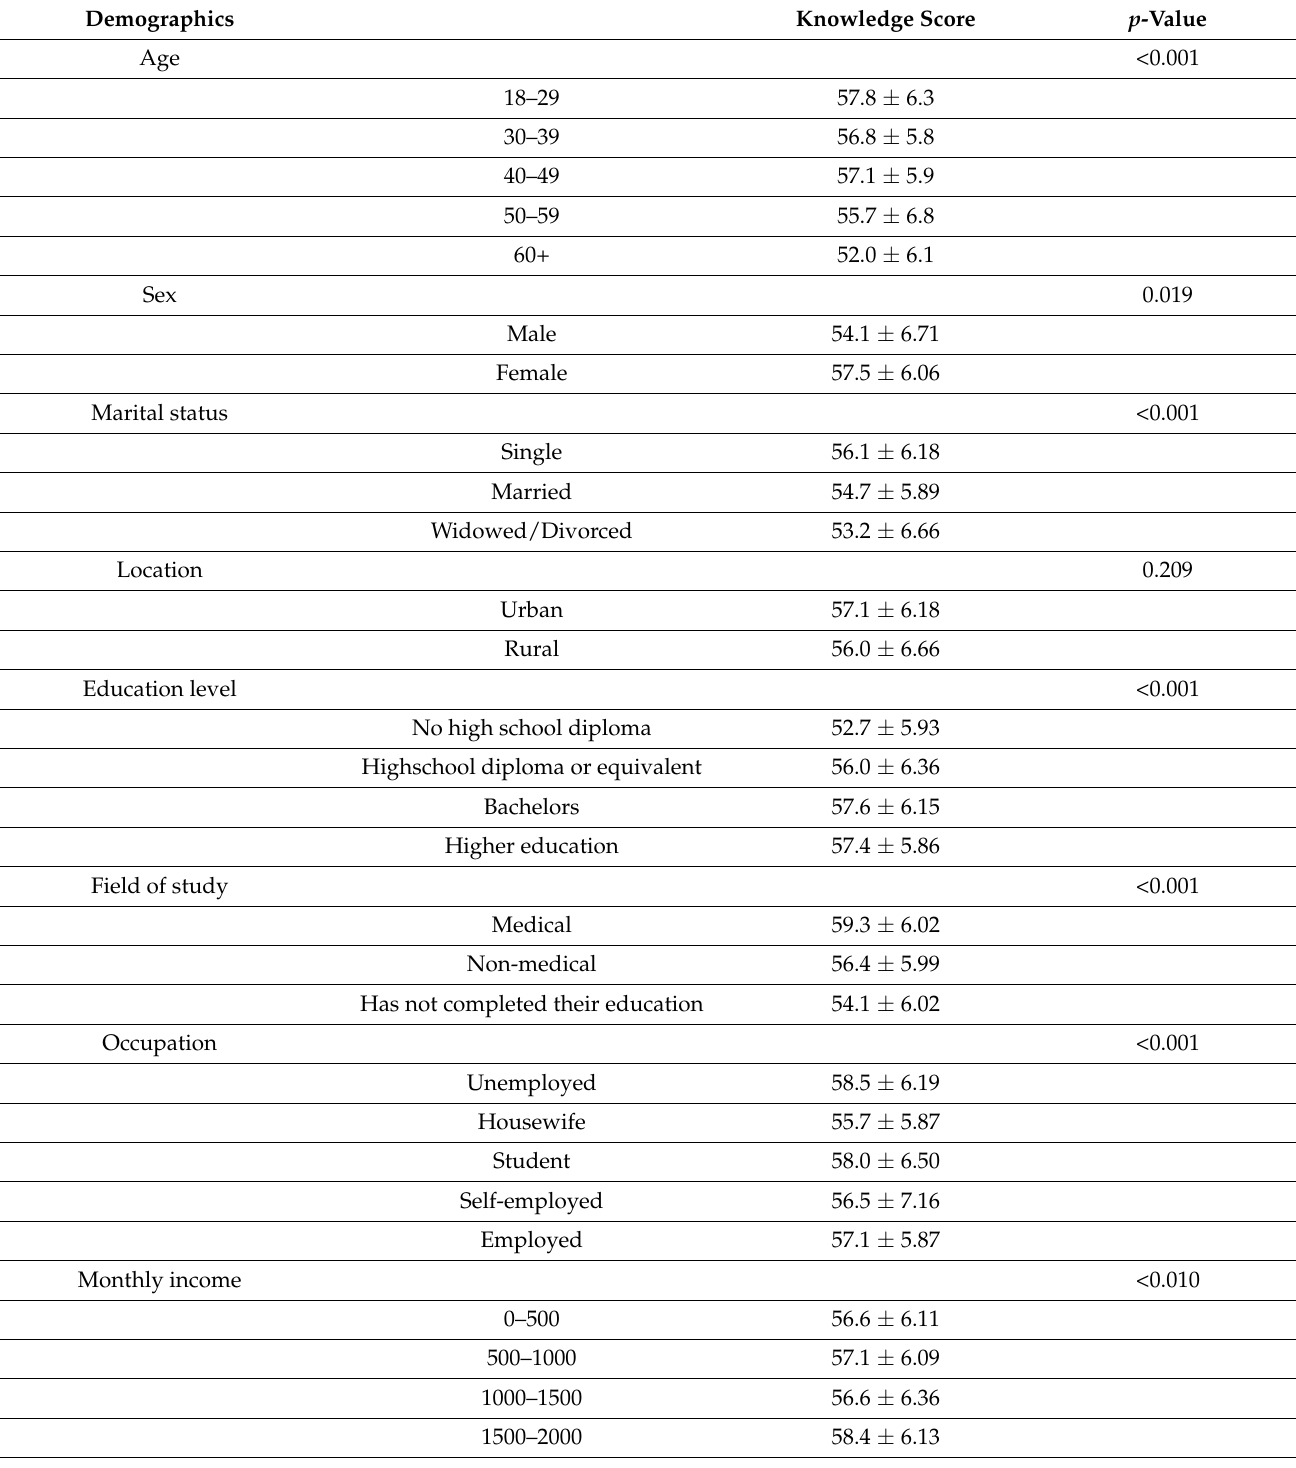
Table 3. Mean score of the knowledge score about PCOS and demographic